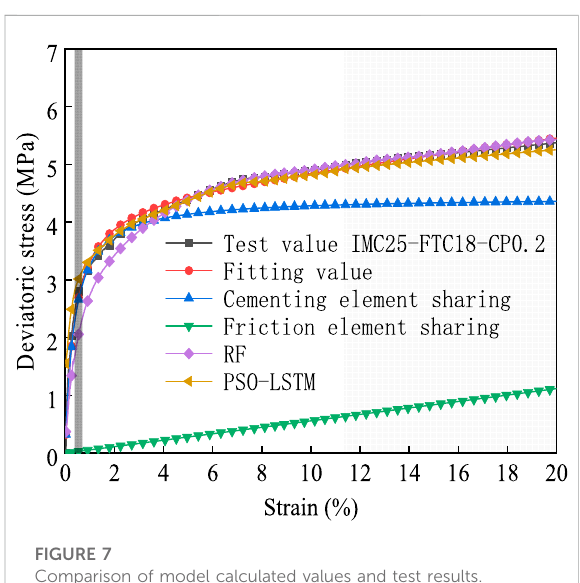
FIGURE 7 Comparison of model calculated values and test results.